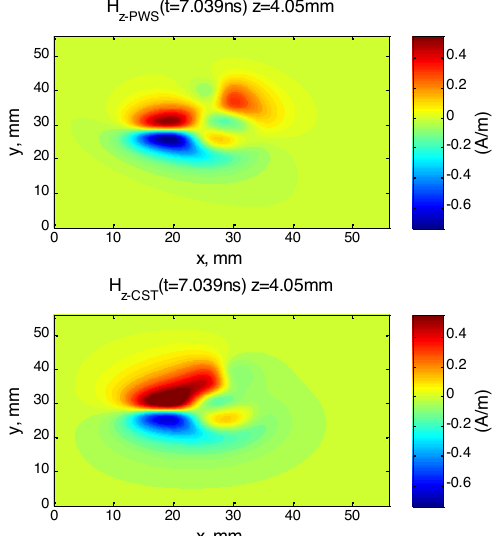
Figure 20: Comparison of H CST simulation and the proposed computation method.